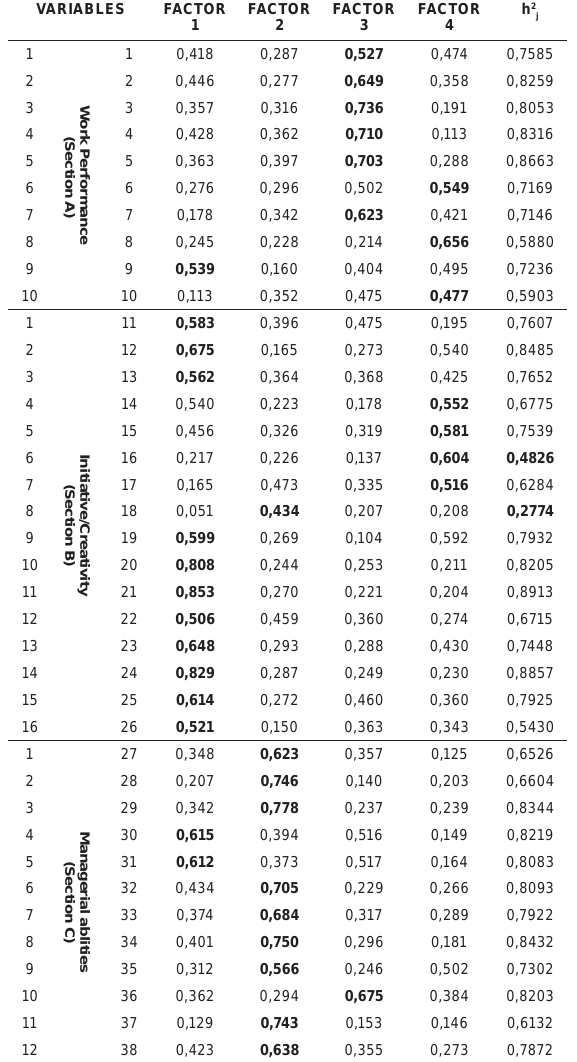
TAbLE 2 Work performance questionnaire rotated factor matrix (varimax